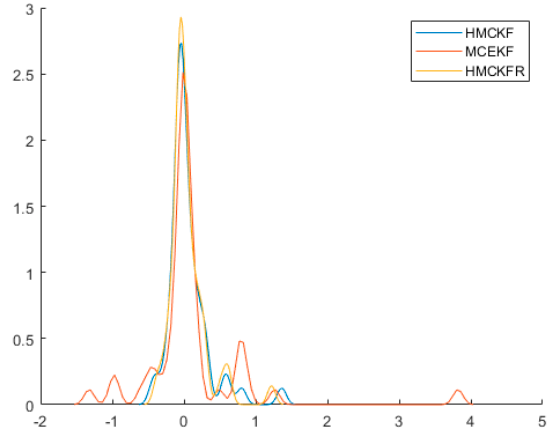
Figure 8. Probability densities of x 1 estimation errors with the three filters in case 2.